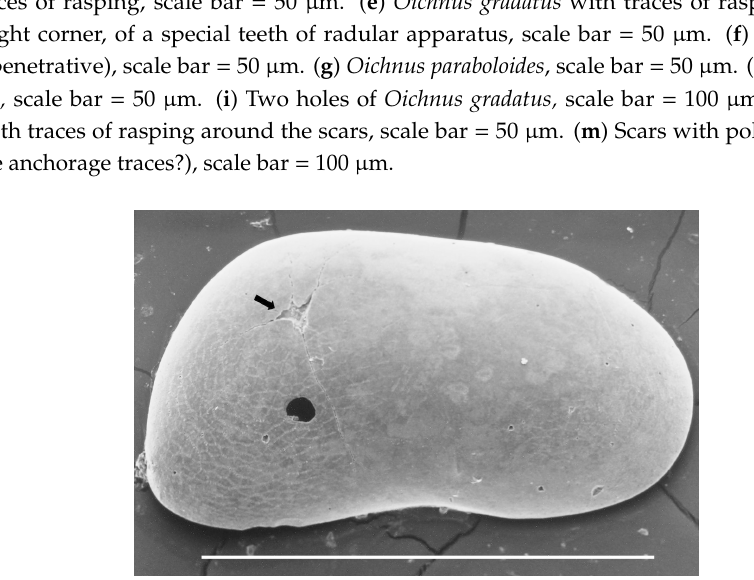
Figure 7. Examples of scratching traces (black arrow). Right female valve of C. basilicii , scale bar = 1